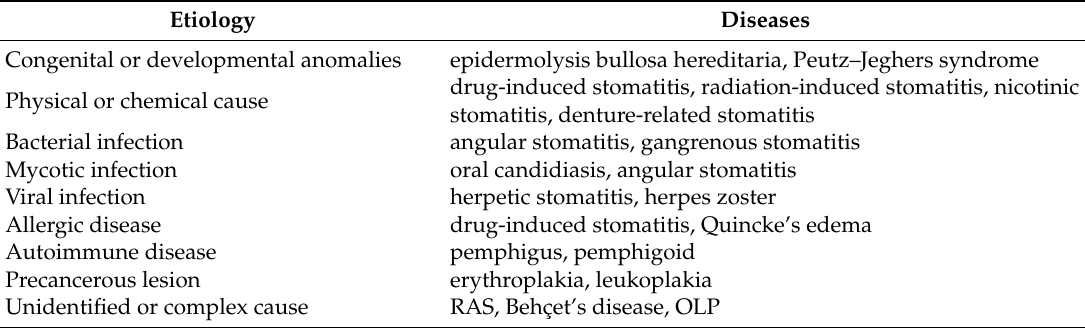
Table 3. Oral mucosal disease; classification by etiology.